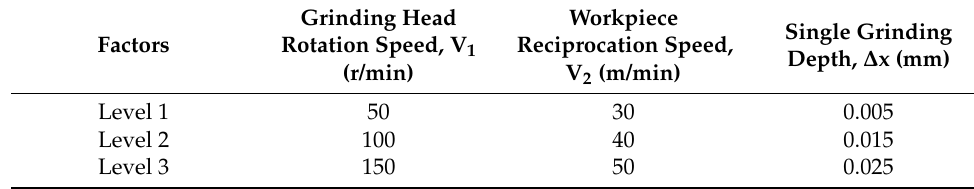
Table 5. BBD experimental design.